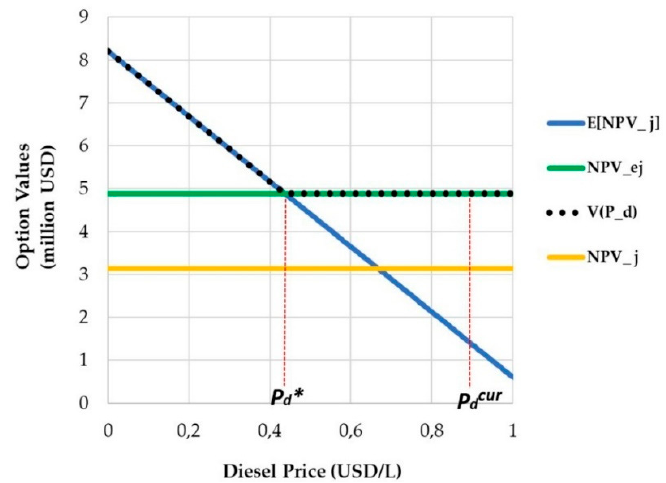
Figure 2. Investment values at initial prices of diesel fuel. P ∗ is the minimum price of diesel for the e-jeepney project; P cur is the current price of diesel. Optimization results are tabulated in Supplementary Material Table S3.